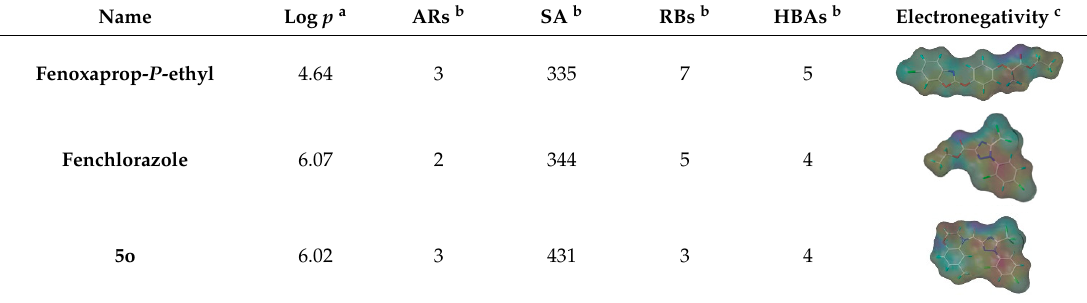
Table 3. Physical and chemical properties comparisons of fenoxaprop- P -ethyl, fenchlorazole and compound 5o .